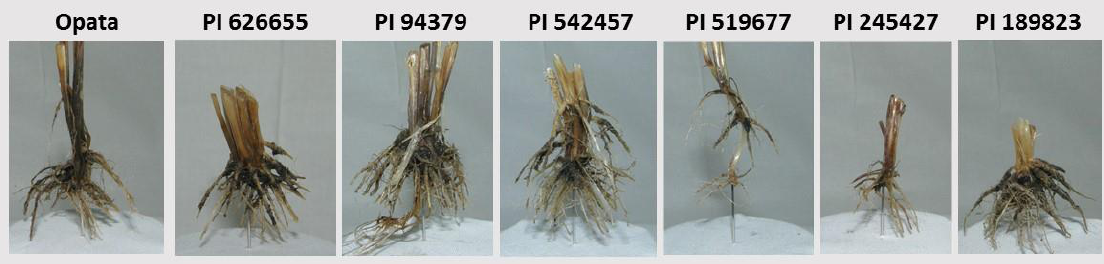
Figure 2. Representative images of crowns after cutting the roots from the 7 lines at maturity.